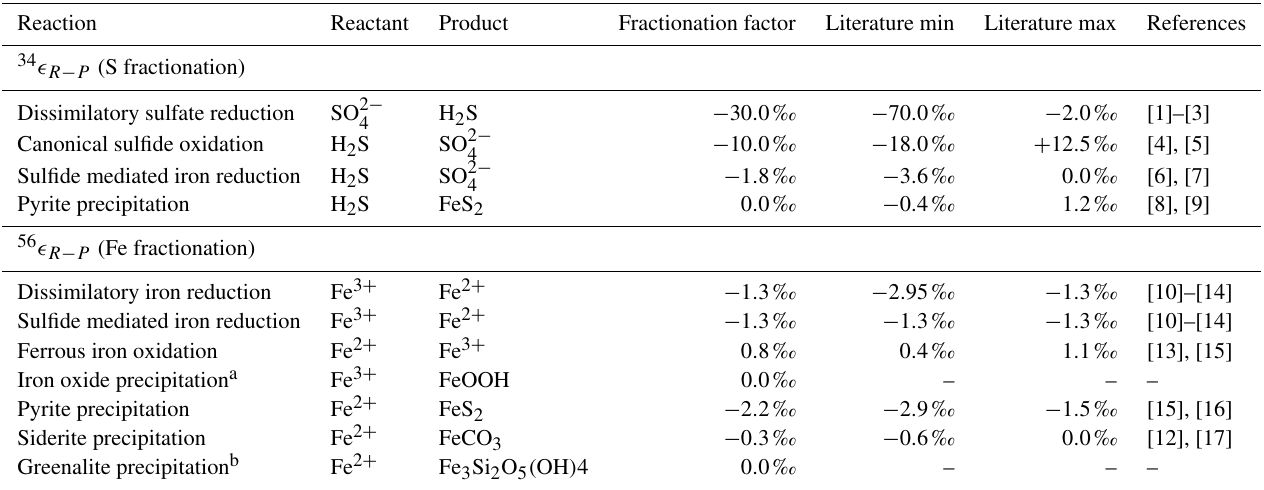
Table 4. Isotope fractionation